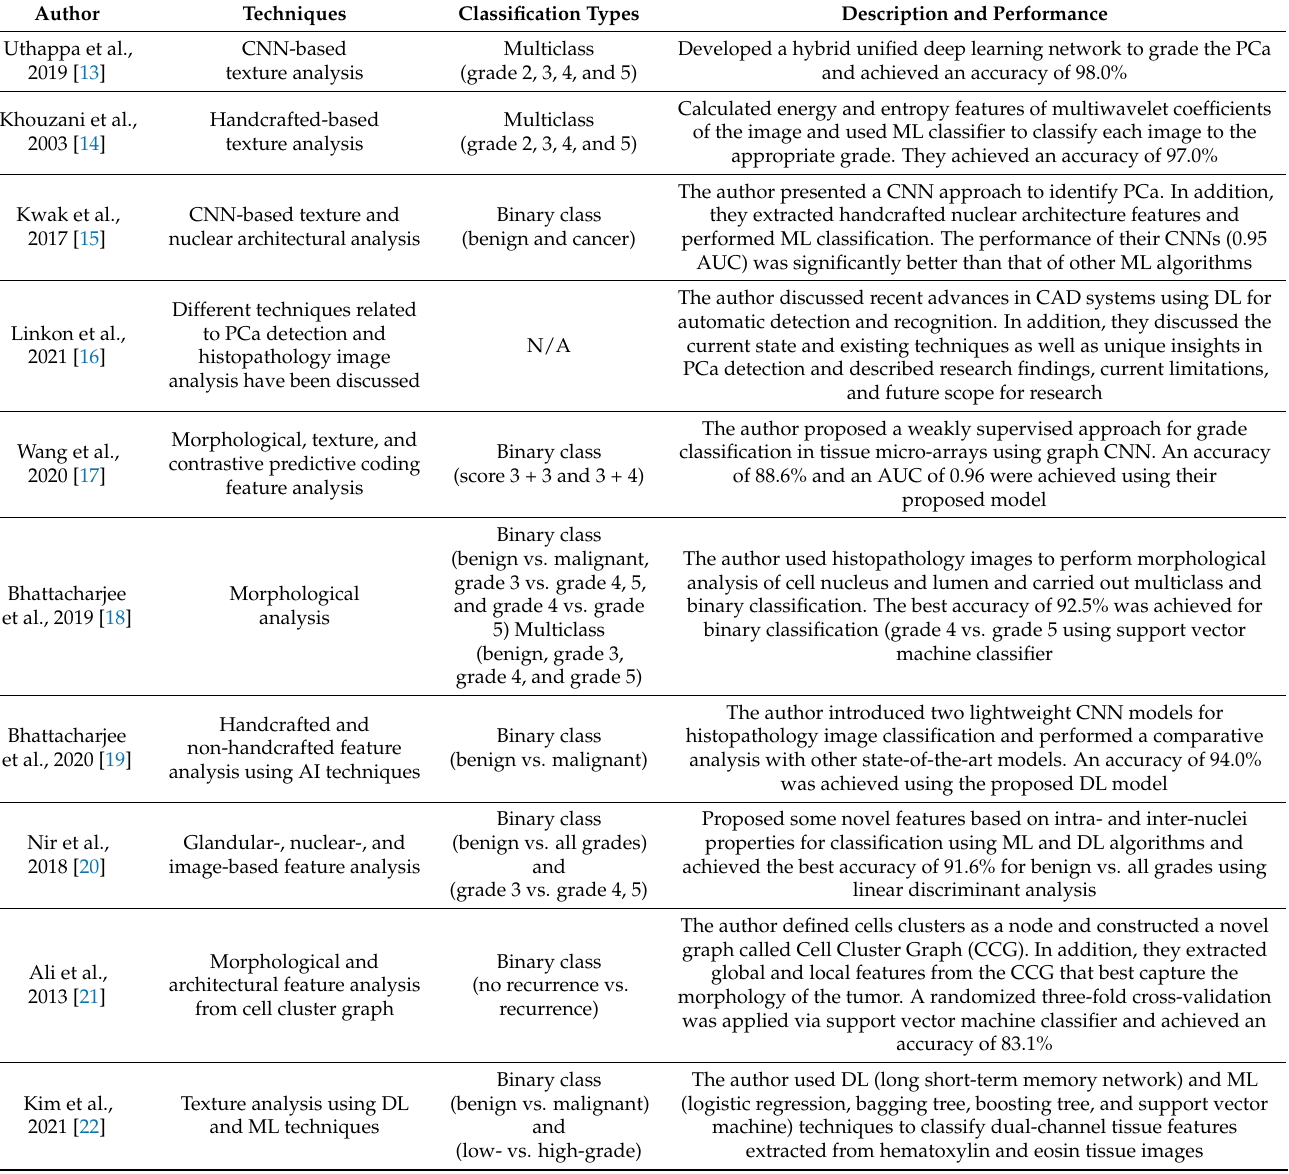
Table 1. Summary of some existing papers that performed PCa analysis using histopathology